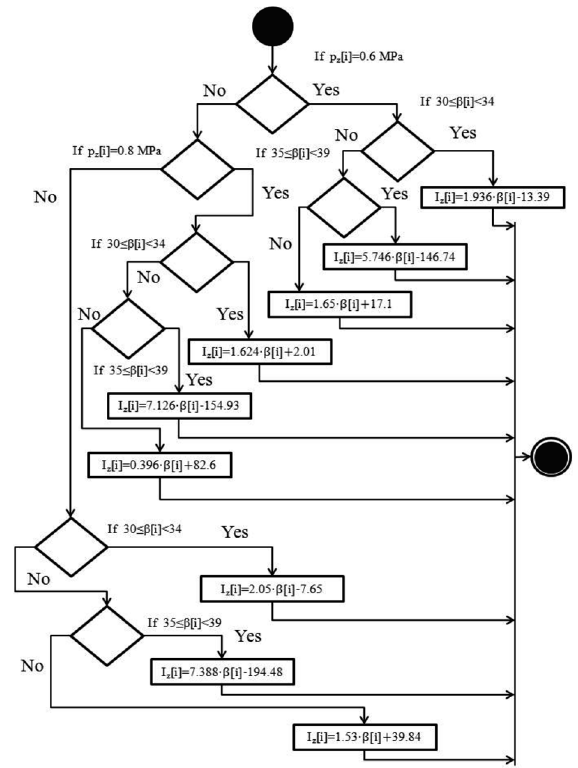
Figure 4. Flowchart of a procedure designed for calculation of sprinkling area functions F